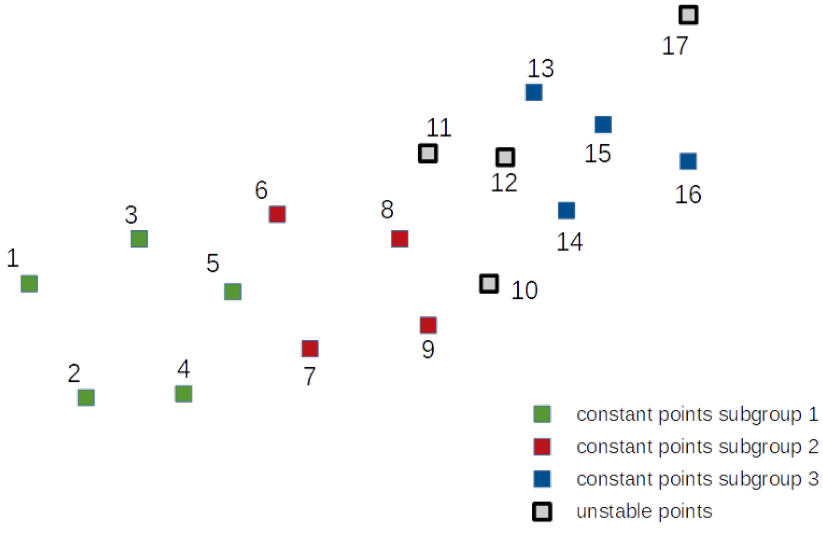
Figure 6. Test network 2 points placement. Three subgroups of mutually stable points were simulated for this network. They are shown in Figure 6 and consist of points 1 to 5 (subgroup 1), points 6 to 9 (subgroup 2) and points 13 to 16 (subgroup 3). The rest of the points are nonstable. The coordinates for